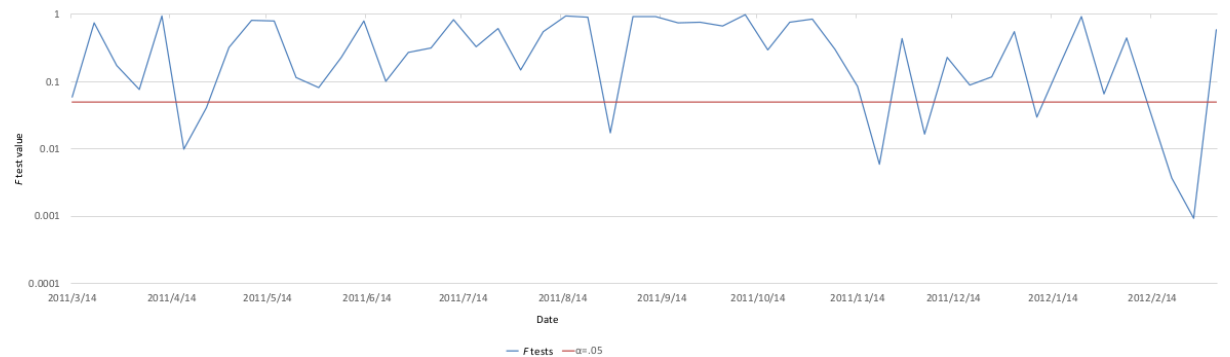
Figure 5. F test for target and retweet (RT) groups by